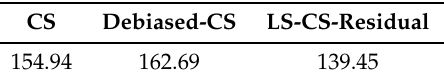
Table 2. Time taken (in minutes) by the three